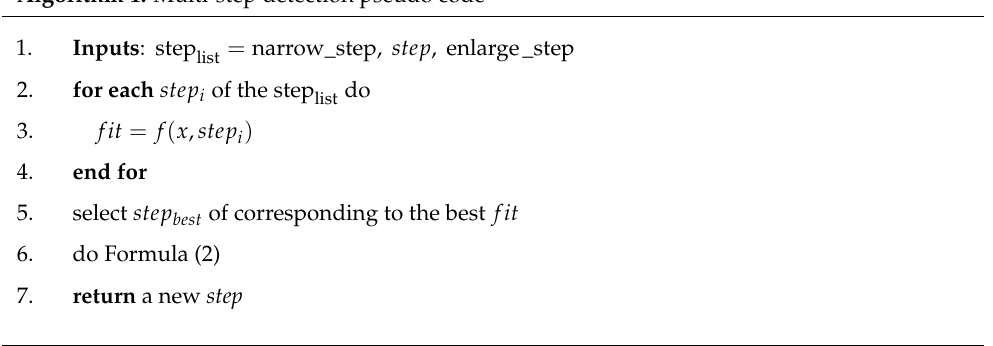
Algorithm 1. Multi-step detection pseudo